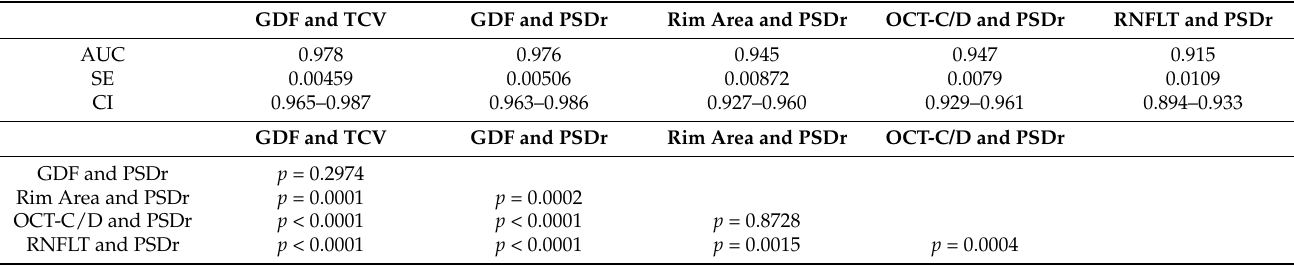
Table 2. Performance of the combination of Laguna ONhE and Cirrus-OCT variables and perimetric variables.